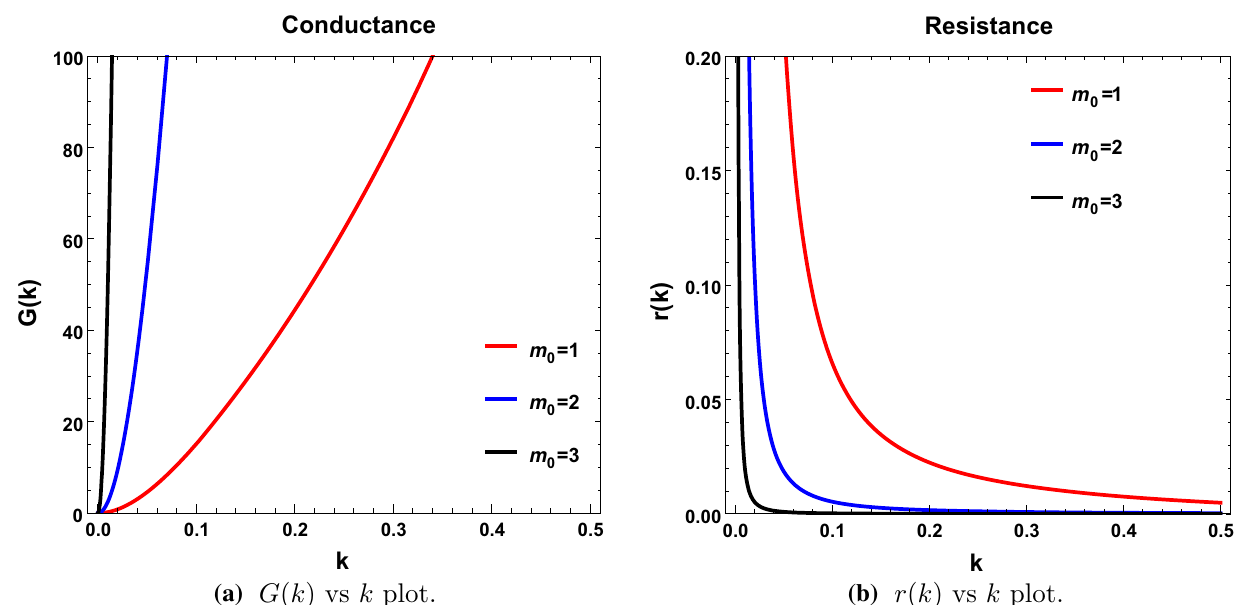
Fig. 9 Wave number dependence of conductance and resistance for the mass profile I is shown here. Here we fix ρ =